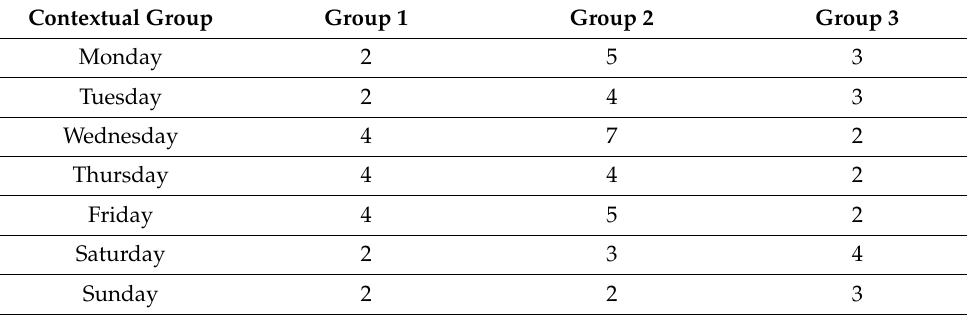
Table 4. Number of activity pattern groups clustered.